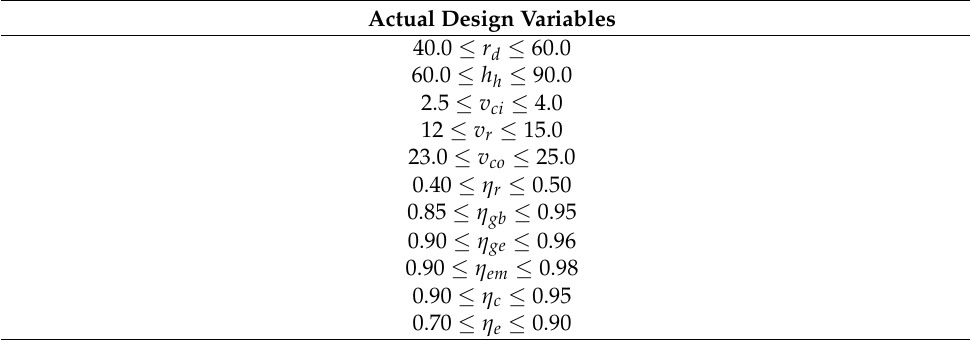
Table 6. Actual design variable